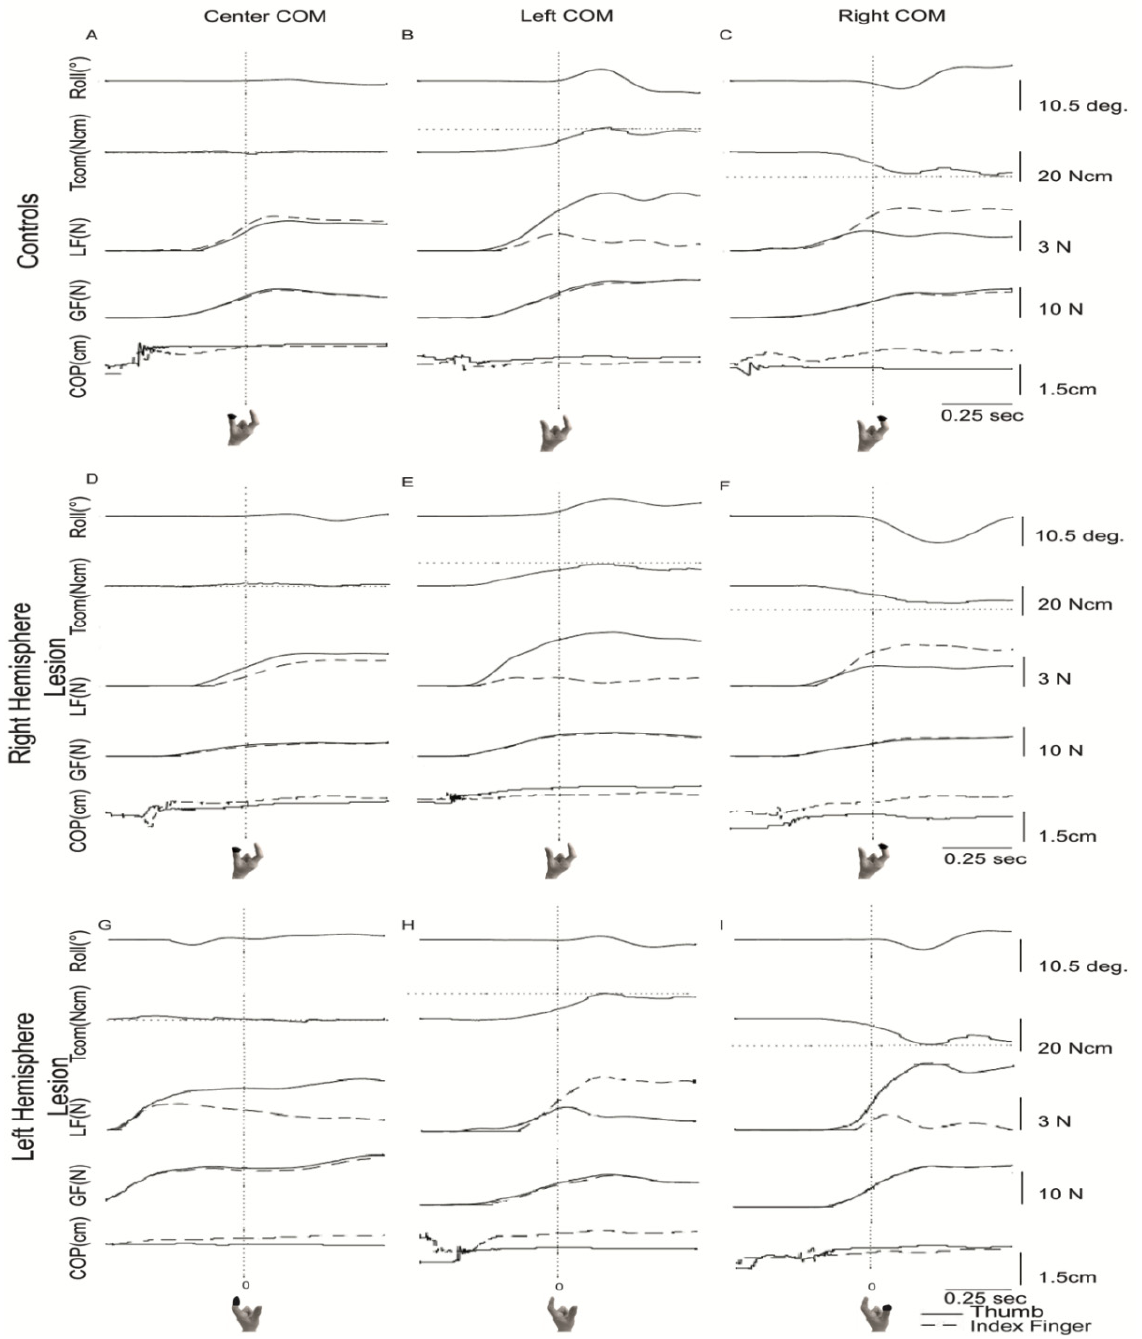
Figure 2. Representative trials for left ( B , E , H ), center ( A , D , G ) and right ( C , F , I ) center of mass locations. Vertical dotted lines indicate lift onset. Horizontal dotted lines for Tcom represent target Tcom. For LF, GF and COP, solid lines represent the thumb, whereas the dashed lines represent the index finger. The black circle on the picture of the hand below the graph represents which digit was on the side the heavy COM was located. Tcom = compensatory torque; COP = center of pressure; LF= Load Force, GF= grip force.